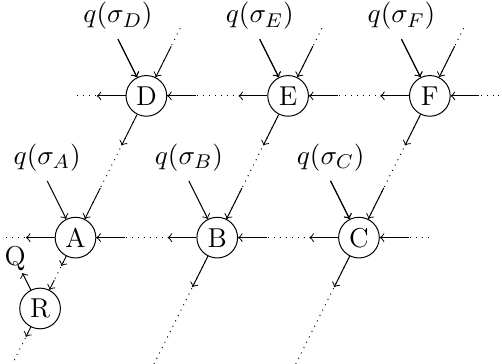
Figure 1: Layout of an example 2 × 3 iPEPS unit cell as used here. Each of the indi- vidual site tensors A , B , C , D , E and F inserts some charge into the network (which also depends on the local state), the special remover tensor R is used to extract a total charge Q from the unit cell. Auxiliary leg contractions are indicated by the dotted lines. The average quantum number on the inter-unit-cell auxiliary legs is zero (with some fluctuations) whereas intra-unit-cell legs can have non-zero average quantum number depending on the values of q ( σ ) and the “routing” of charges through the unit